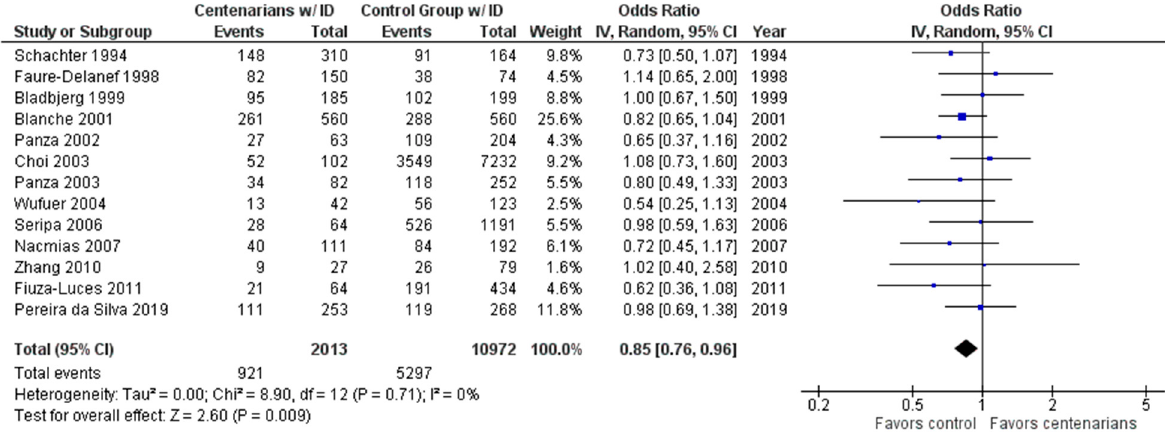
Figure 3. Comparison of ID genotype frequency in centenarians and control groups. The ages of centenarians and control groups are described in Table 1. The p- value is indicated by P in the Figure.